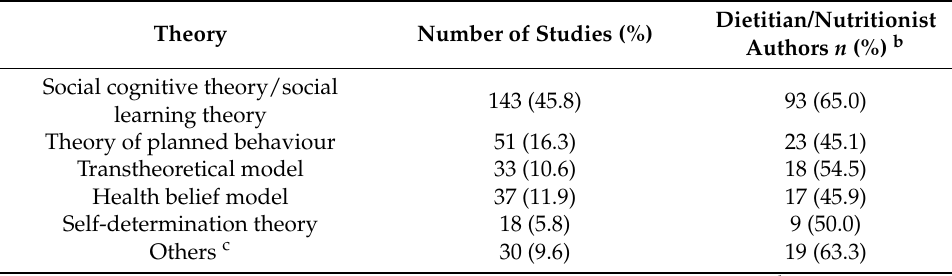
Table 2. Usage of different behaviour change theories in the healthy eating interventions a .